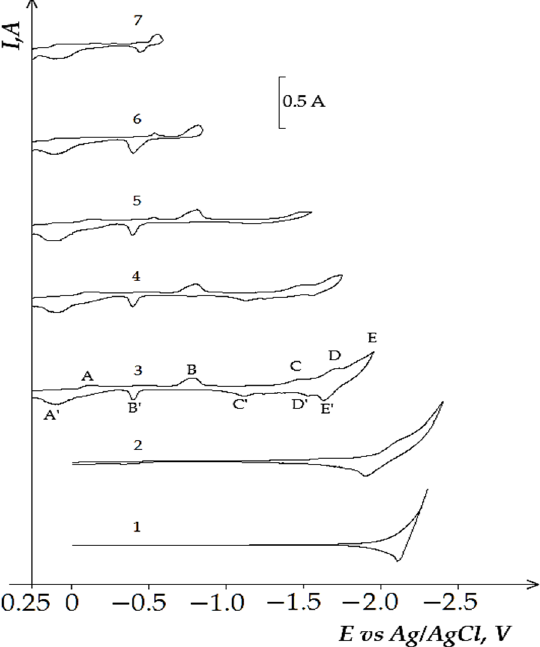
Figure 7. Cyclic voltammograms of electrochemical coreduction of Dy 3+ and Ni 2+ ions on the tungsten electrode in the equimolar KCl-NaCl melt at 973 K, polarization rate of 0.2 V/s, and different reverse potentials: curve 1 ( − 2.3 V), curve 2 ( − 2.4 V), curve 3 ( − 2.0 V), curve 4 ( − 1.75 V), curve 5 ( − 1.76 V), curve 6 ( − 0.8 V), curve 7 ( − 0.6 V). Concentrations of DyCl 3 : curve 1—0 mol/cm 3 , curves (2–7)—3.0 × 10 − 4 mol/cm 3 . Concentrations of NiCl 2 : curves (1 and 2)—0, curves (3–7)—5.0 × 10 − 5 mol/cm 3 . A square of the cathode is 0.4 cm 2 .